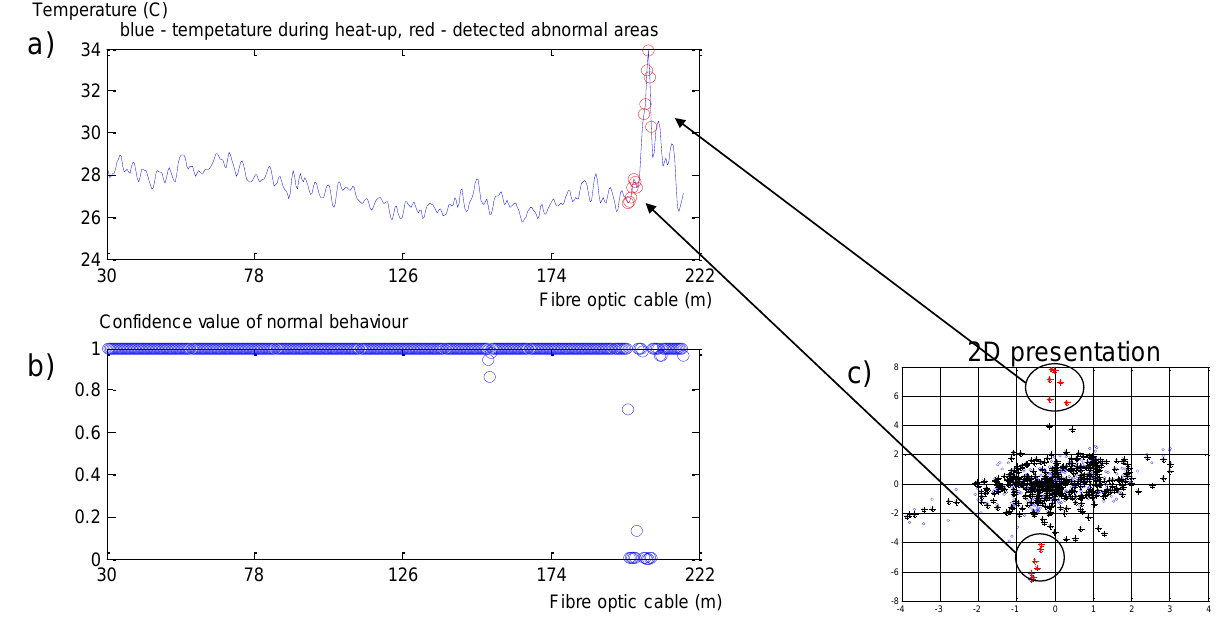
Figure 16. Non-saturated part of the Rhine levee detection: 10th minute of heat-up. ( a ) Input time series. ( b ) The calculated confidence values: values close to 1 are related to normal behaviour, close to 0 indicates anomaly. ( c ) The 3rd (X axis) and 4th (Y axis) levels of decomposition after post-processing: blue—training set, black—test set related to normal behaviour, red—test set related to